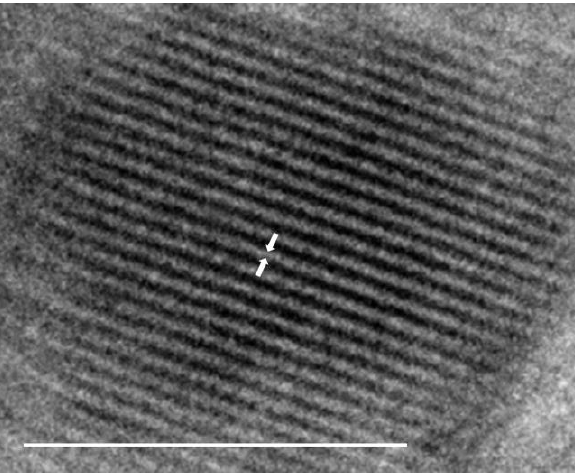
Figure 4. TEM image of spherical SPION core indicating the unit cell spacing. The scale bar is 5 nm, and the arrows indicate a spacing of 4.1 angstroms.